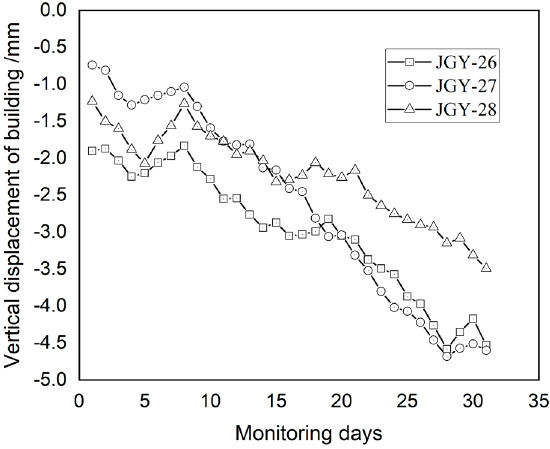
Figure 8. History curve of building settlement.